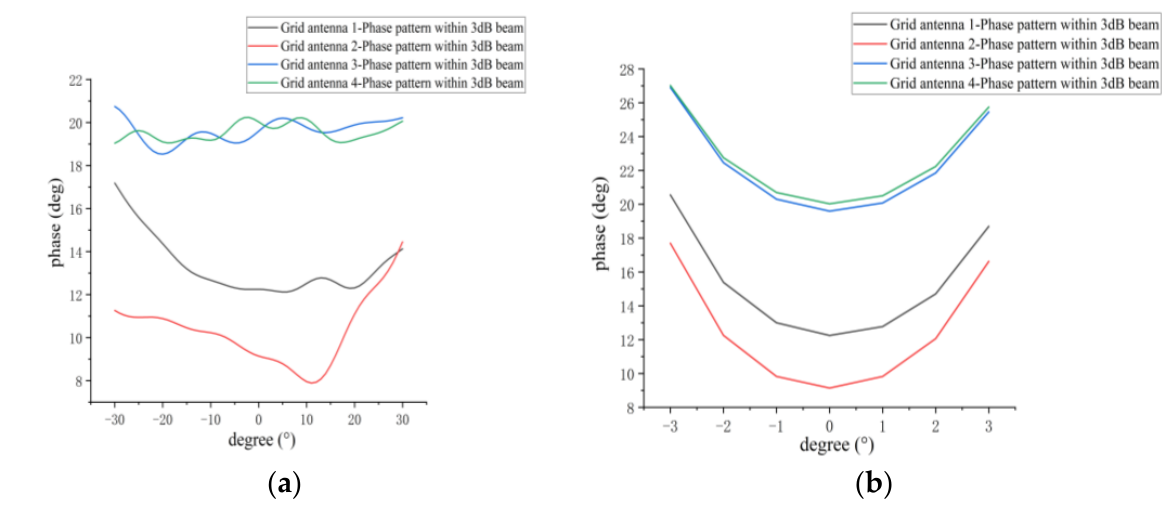
Figure 12. Simulated phase pattern of 3-dB beamwidth for every antenna element in sparse array: ( a ) E-plane phase pattern; ( b ) H-plane phase pattern. Table 3. Simulated phase ranges and fluctuations of 3-dB beamwidth phase patterns in E and H planes for every antenna element.